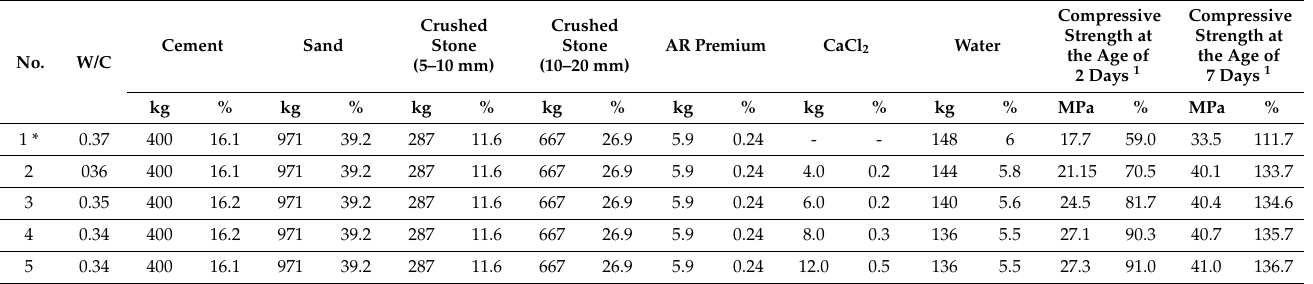
Table 16. Compositions of RHC containing CaCl 2 .